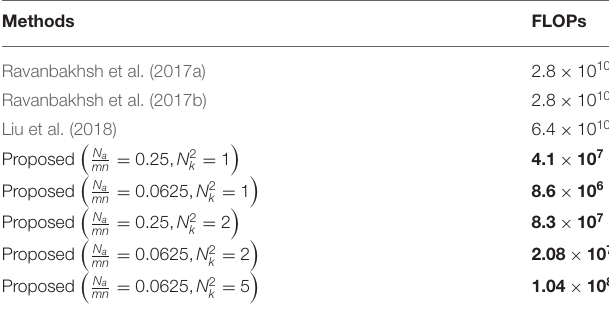
TABLE 7 | FLOPs (Floating Point OPerations) of conventional frame-based anomaly detection networks in comparison to the proposed network ( 128 × 128 ) .